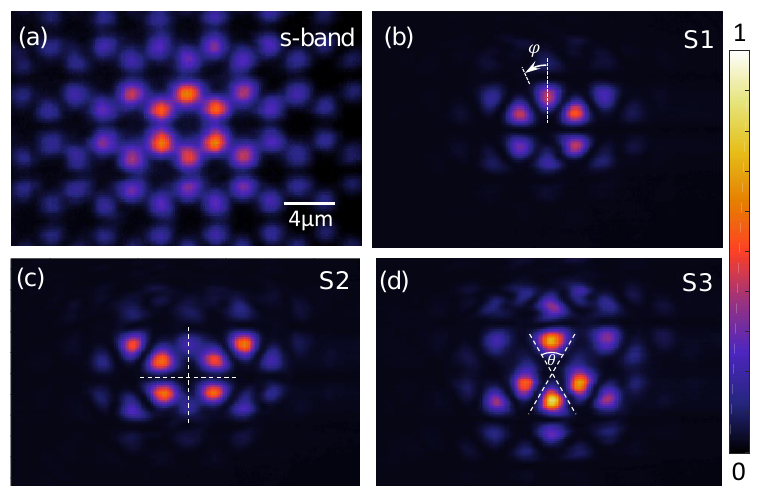
Figure 4: Real-space of emission of the energy selected top states of the s-band at low power 15 mW (a), and gap modes S1 (b), S2 (c) and S3 (d) at 105 mW. The intensity in each panel has been independently